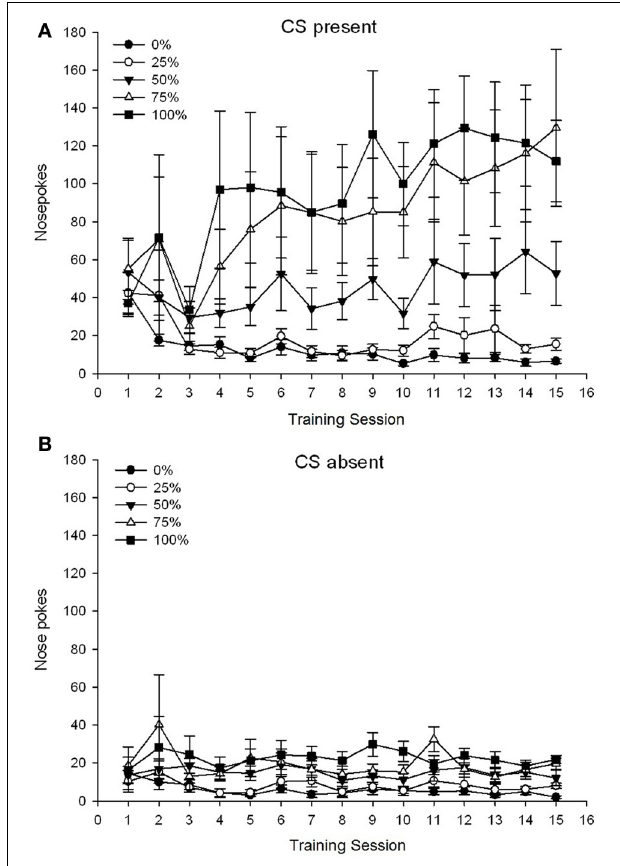
FIGURE 3 | Mean (SE) approach responses (nose pokes) on 15 sucrose training sessions in groups of Sprague Dawley rats ( n = 8/group) exposed to sucrose reward (10% solution) delivered under 0, 25, 50, 75, or 100% variable schedules. The conditioned stimulus was a light (120s). Group 0 received the same number of rewards as group 100 in the absence of conditioned stimuli. (A) Scores when CS was present (5s × 20 trials). (B) Scores when CS was absent (average for 5 × 20 s while light was off).